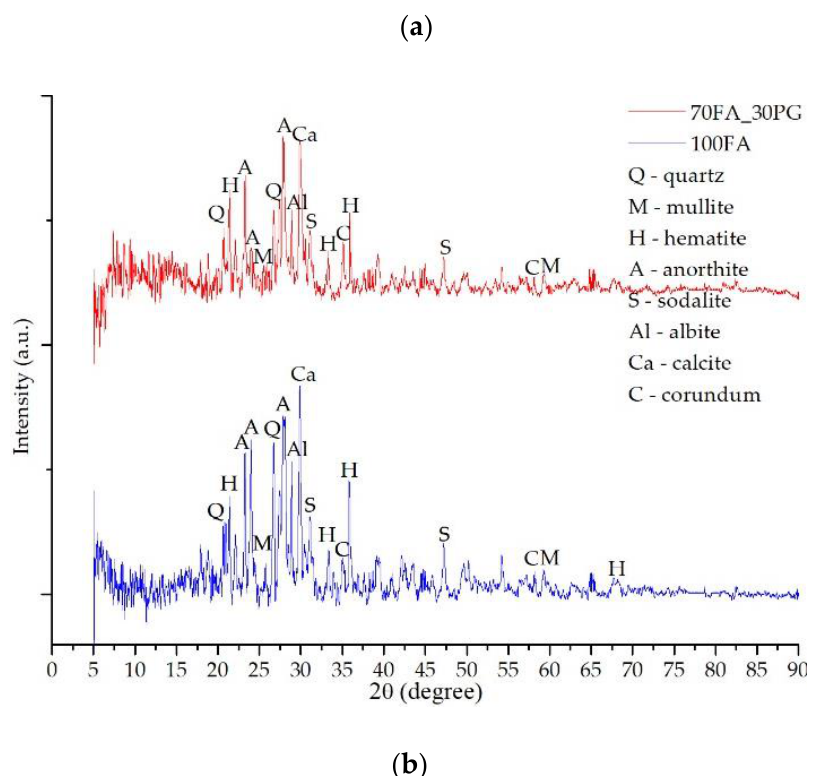
Figure 8. XRD patterns of sample 100FA and sample 70FA_30PG: ( a ) prior TG-DTA analysis; ( b ) after TG-DTA analysis.